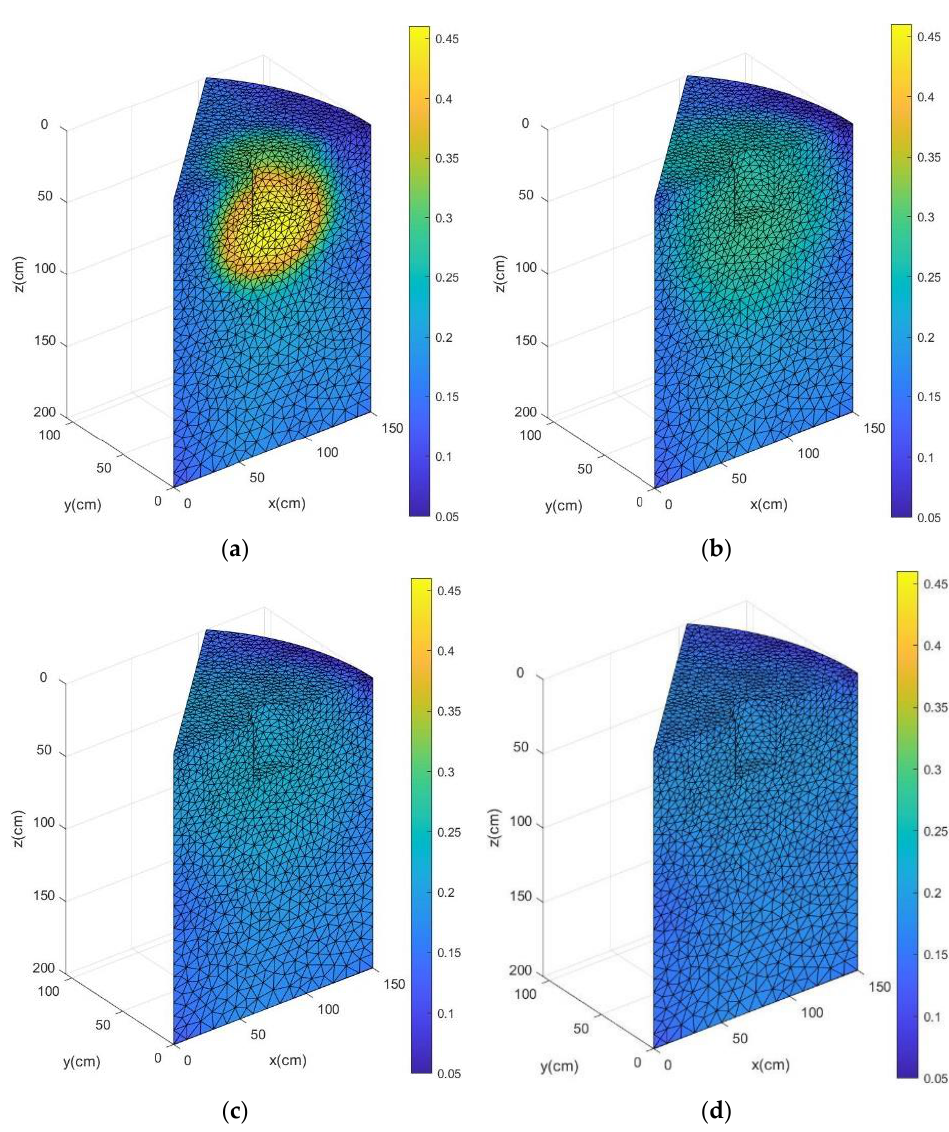
Figure 9. Simulation of soil moisture content distribution on different days. ( a ) Soil moisture content after 1 day of irrigation; ( b ) Soil moisture content after 5 days of irrigation; ( c ) Soil moisture content after 11 days of irrigation; ( d ) Soil moisture content after 17 days of irrigation. Table 6. Calculation of statistical indexes of daily soil moisture content for water storage pit irriga- tion.